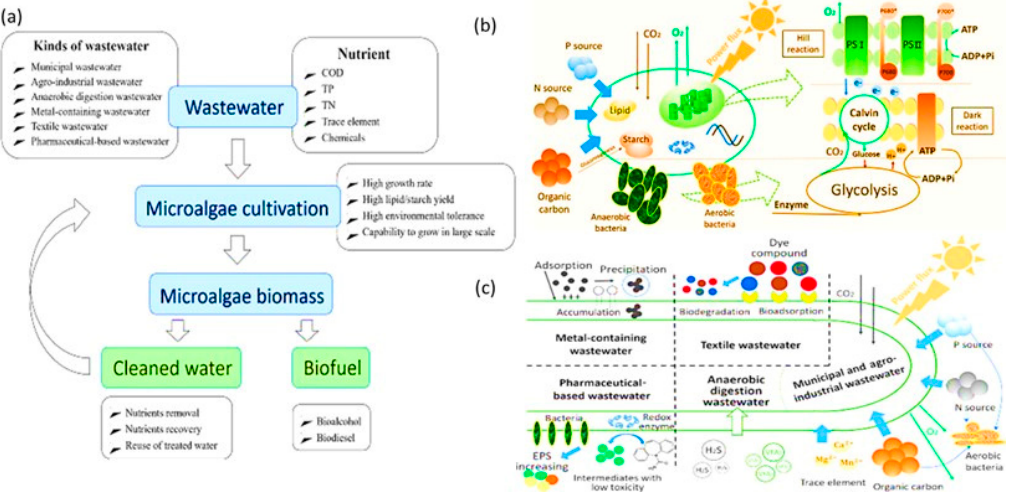
Figure 10. ( a ) Schematic presentation of simulations of wastewater treatment with microalgae biomass cultivation. ( b ) Nutrient and energy flow in microalgae-bacteria consortium. ( c ) Mechanisms of various wastewater treatments using microalgae and bacteria [101]. Reprinted/adapted with permission from Ref. [101]. 2022, Elsevier B.V.